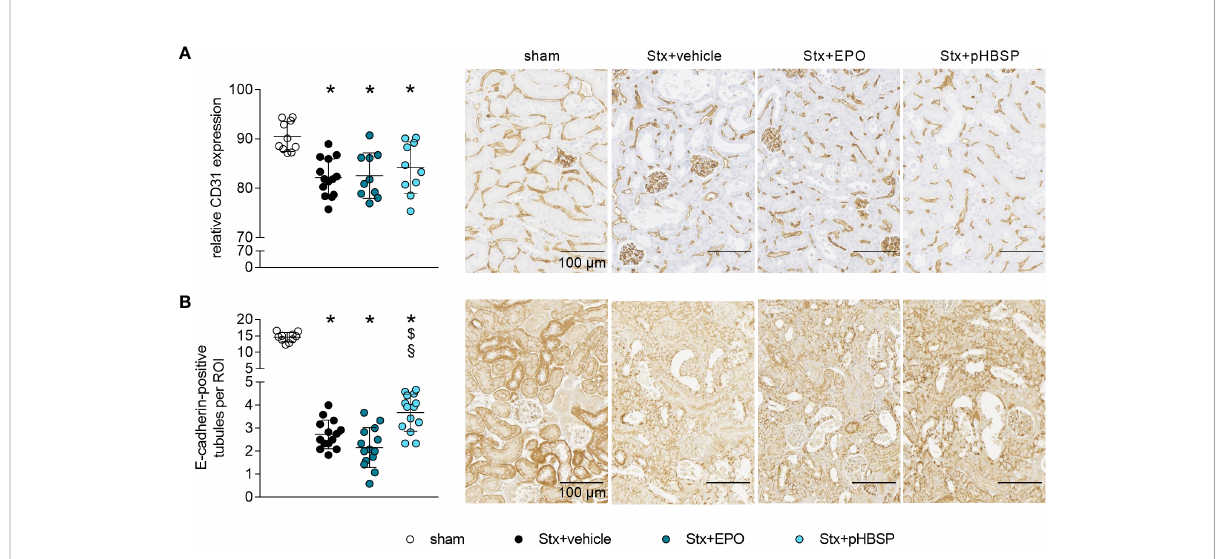
FIGURE 5 Effect of EPO and pHBSP treatment on intrarenal barriers in mice with HUS. Intrarenal barriers were assessed on day 7 of HUS experiment. Quanti fi cation data as well as representative images (scale bar 100 µm) of immunohistochemical (A) CD31 staining (sham n = 10, Stx+vehicle n = 14, Stx+EPO n = 10, Stx+pHBSP n = 10) and (B) E-cadherin (sham n = 10, Stx+vehicle n = 14, Stx+EPO n = 14, Stx+pHBSP n = 14), in renal sections of sham mice and mice subjected to Stx. (A, B) Data are expressed as scatter dot plot with mean ± SD. *P < 0.05 vs. sham, $ P < 0.05 vs.